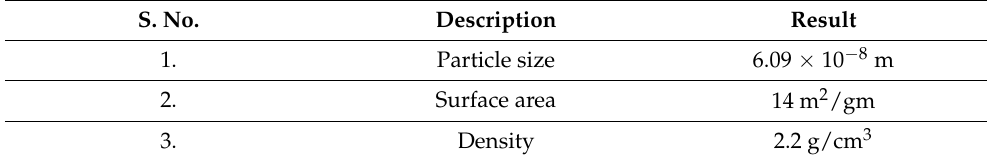
Table 5. Physical properties of silica fume.